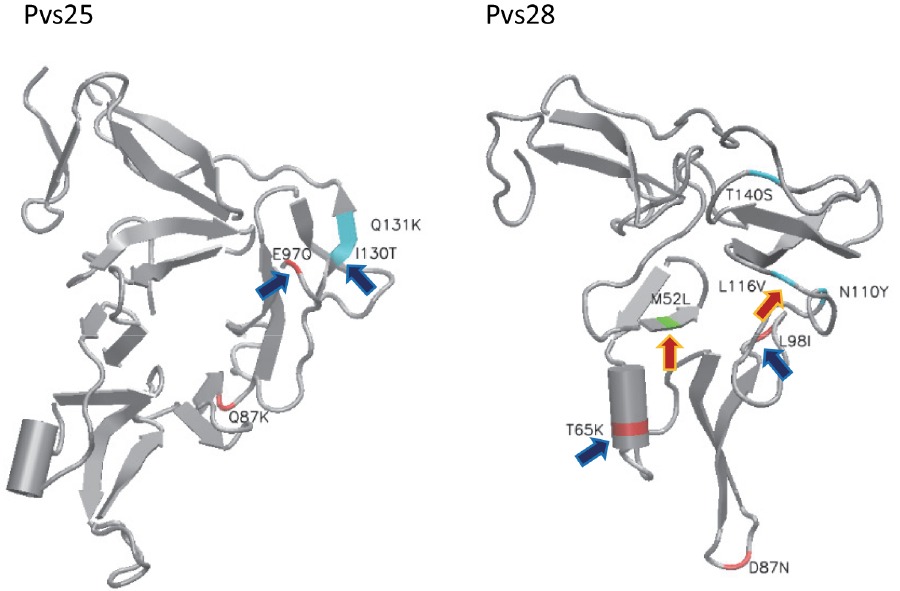
Fig 2. Representation of 3D structures of the Pvs25 and Pvs28 proteins. The mapped amino acid substitutions are those with a frequency > 1%. Arrows indicate codons putatively under positive selection under the model implemented in the random effects likelihood (REL) method (blue arrows: Bayes Factor > 10 < 50; red arrows: > 50). All substitutions with their frequencies and structural location are listed in S1 and S2